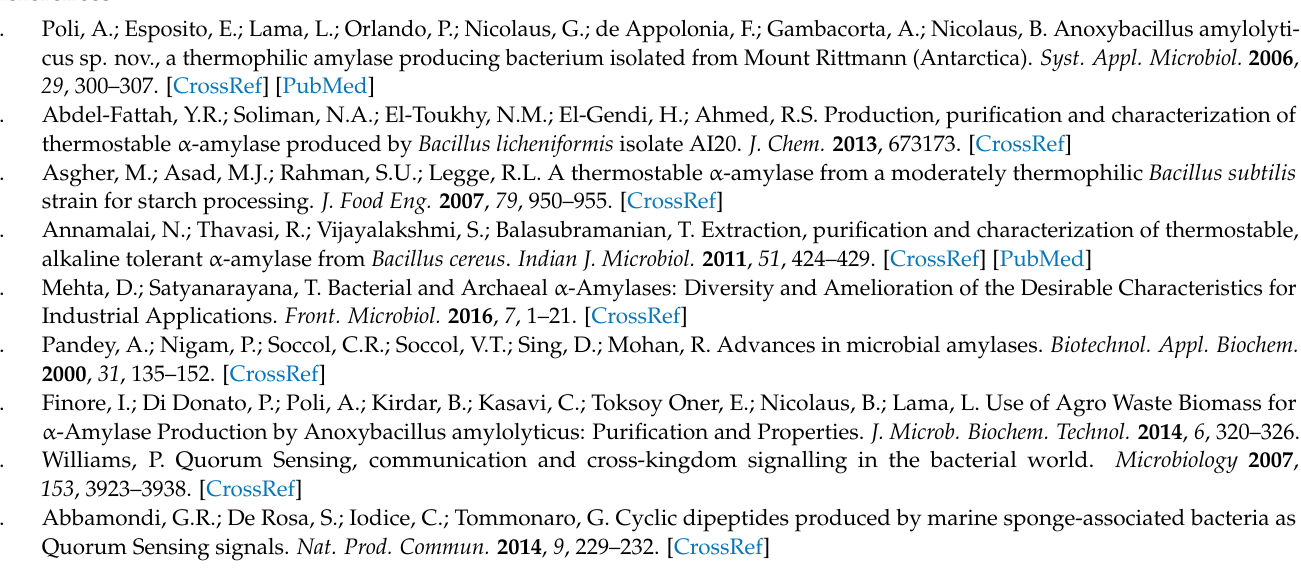
Figure S2: % of starch hydrolysis by using α -amylases from bacterial growth in standard condition, with CIN (3 mgmL − 1 ) and C4-HSL (10 µ M), Fugure S3: α -Amylase activity from a culture containing 1 mg mL − 1 of